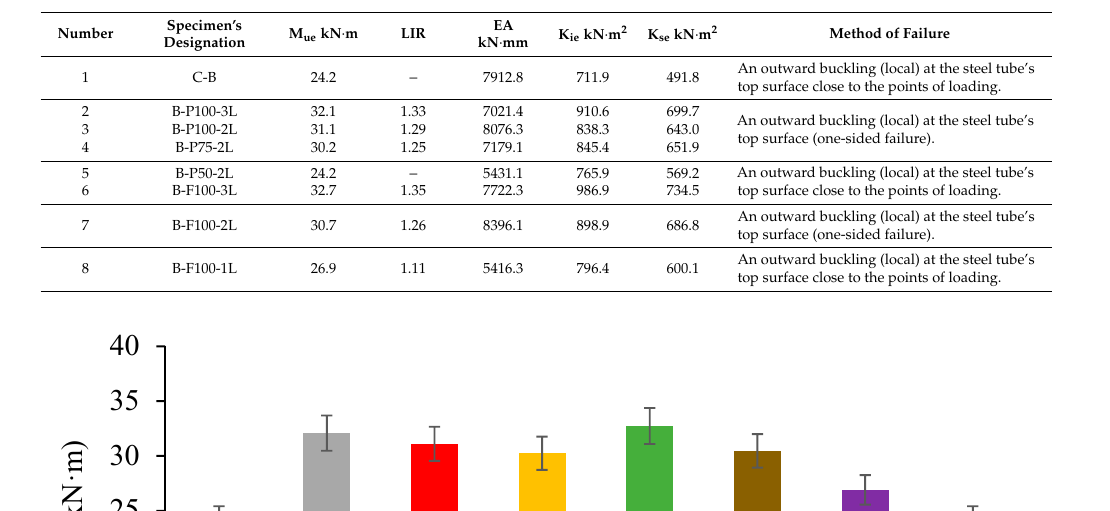
Table 5. HPCFDST beams results.